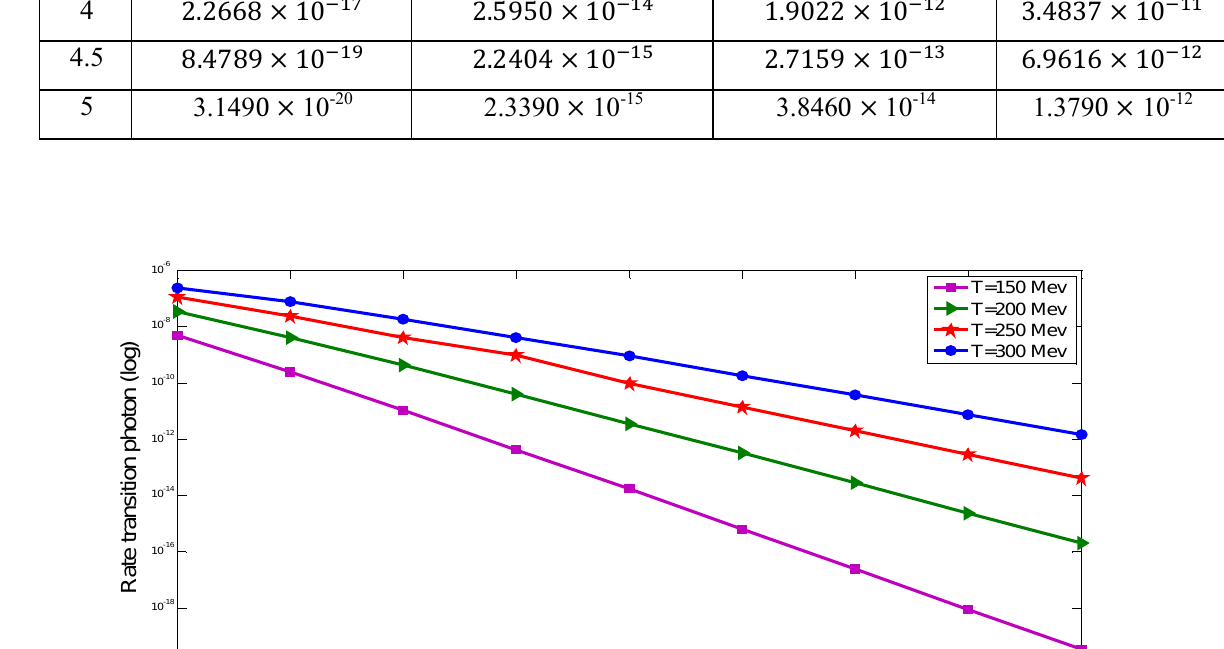
Fig. 1: Photons rate (cid:1337) system with (cid:2170)